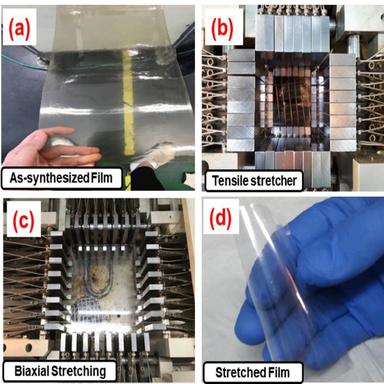
The overall process of biaxial stretching of PCTN film; (a) as-synthesized randomly oriented PCTN film, (b) tensile stretcher used in this study, (c) biaxial stretching of PCTN film, (d) biaxially stretched, transparent, and flexible PCTN copolyester film.